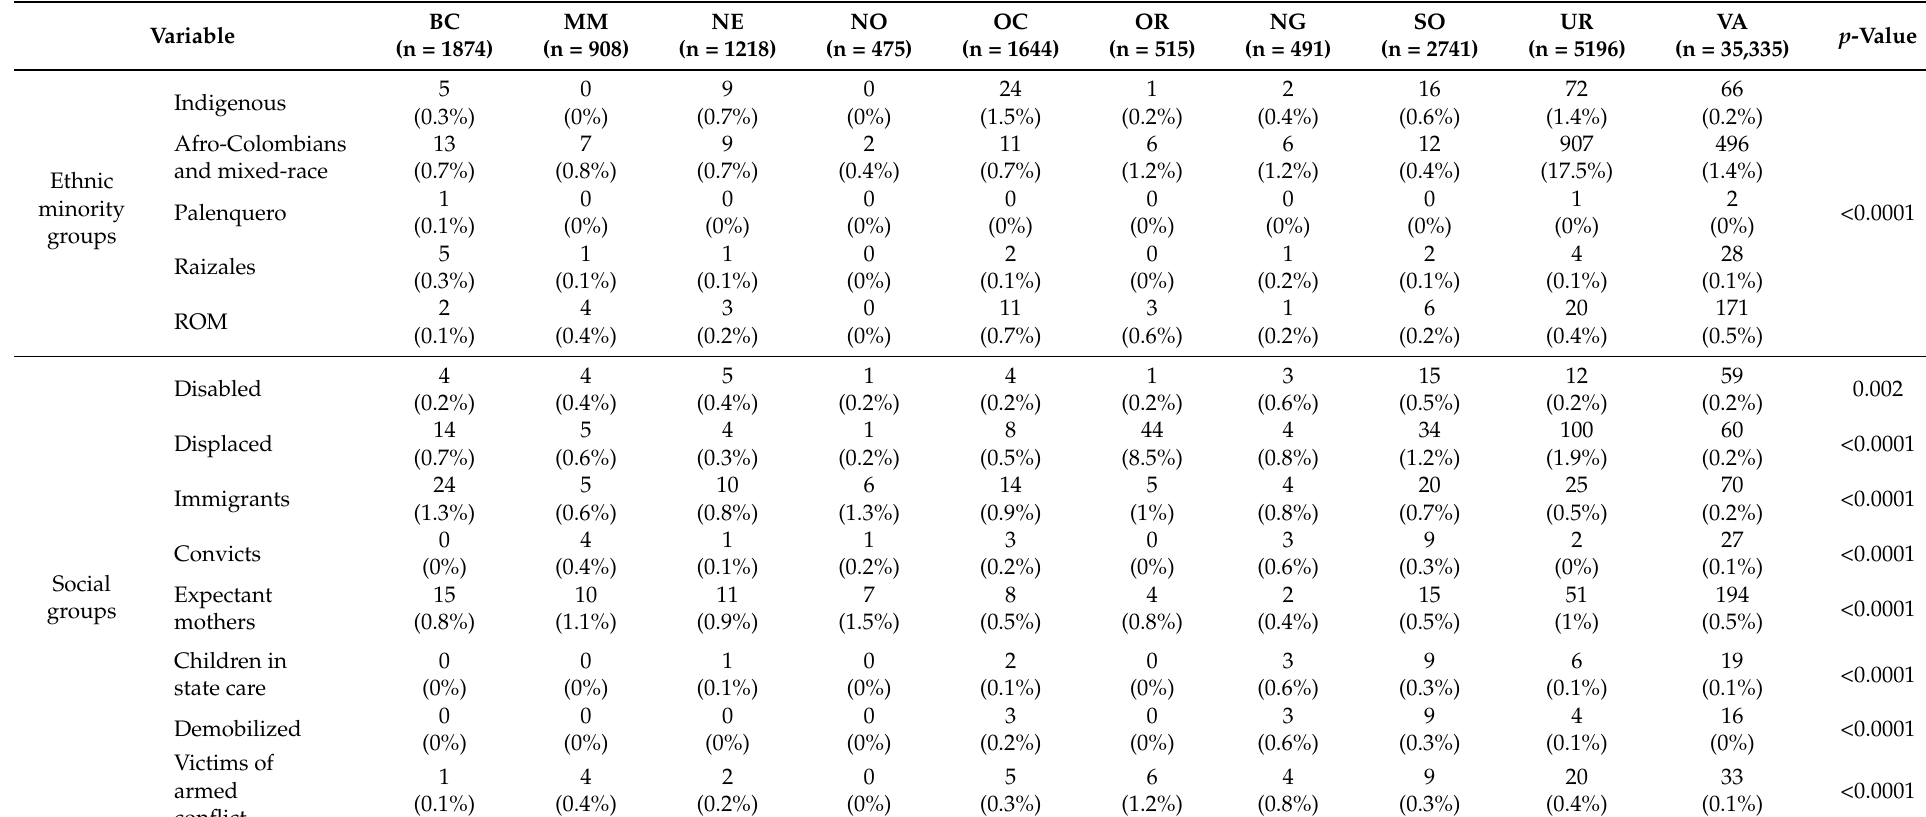
Table 5. Socio-demographic characteristics among patients, according to subregion location (part